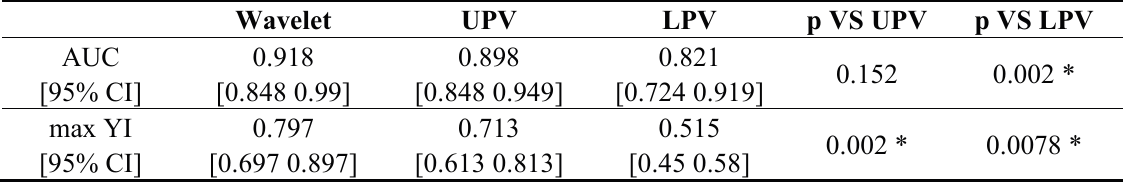
Table 1. Performance of the three presented features. Area under the Curve and maximum Youden’s Index values are reported with 95% Confidence Intervals. In the last two columns the p-values of the comparisons between features are reported. * = statistical significant difference (considering the Bonferroni correction for multiple comparisons).